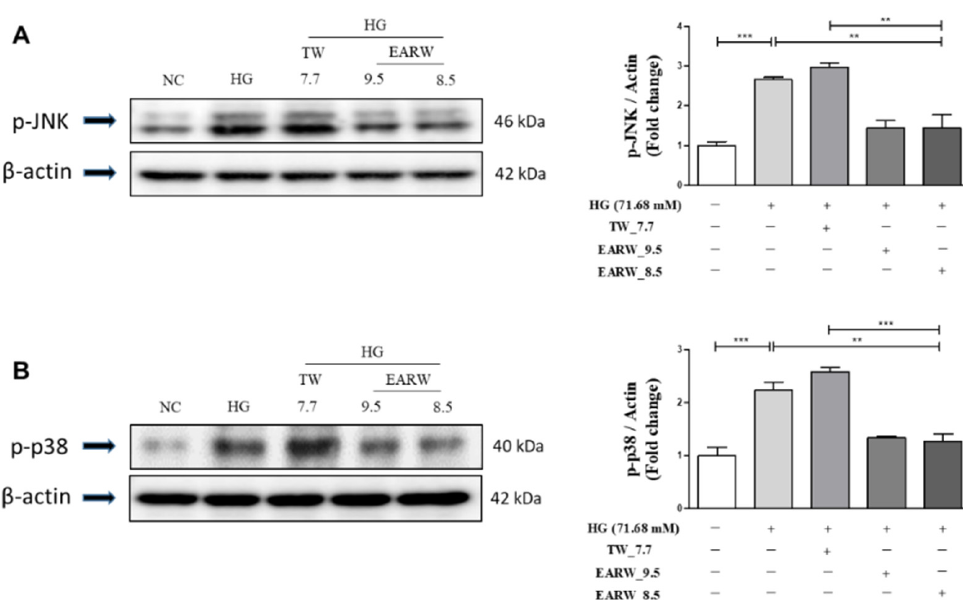
Figure 3. MAPK proteins p-JNK and p-p38 were analyzed to study the effect of EARW_8.5 after HG-induction. ( A ) Western blotting and its relative intensity for p-JNK were analyzed. ( B ) Western blot and its relative intensity for p-p38 were analyzed. Values were calculated in mean ± SEM. ** p < 0.01 and *** p < 0.001 indicate significant differences tested with ANOVA.